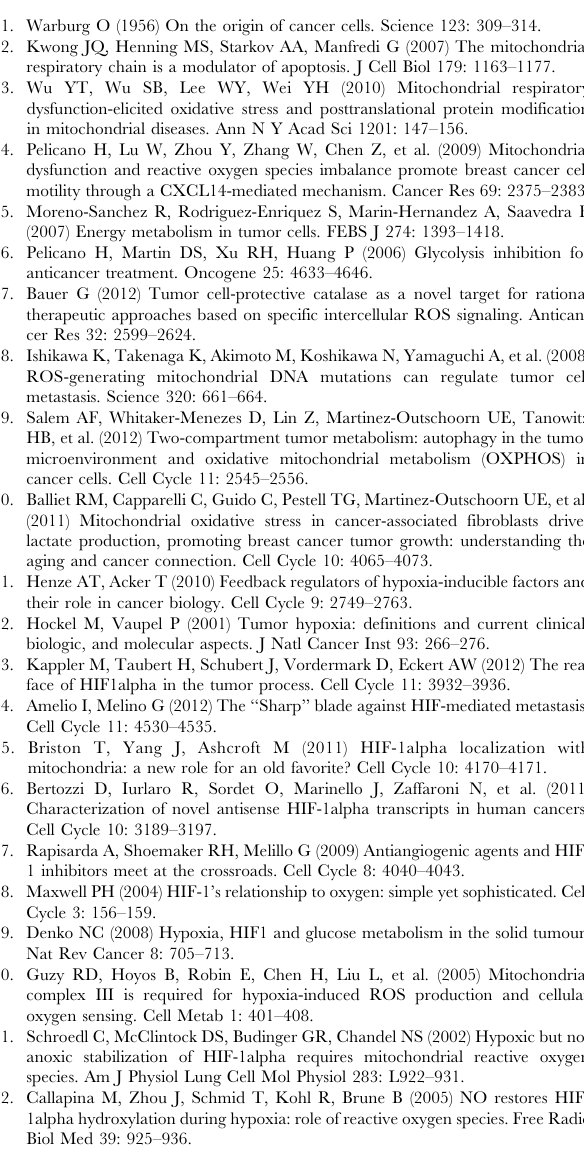
reagents was measured by wound healing assay. B, Migration assay was performed in C subclone cells treated with indicated reagents. C, Invasion capacity of C subclone cells treated